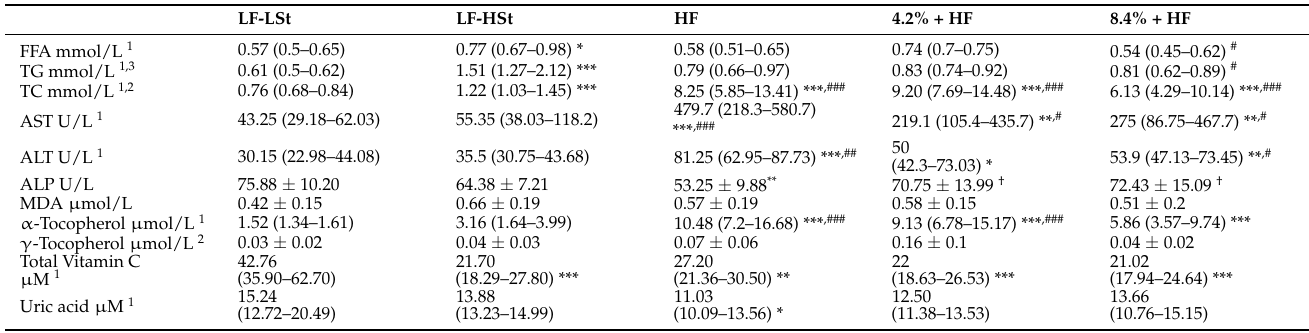
Table 1. Plasma biochemical